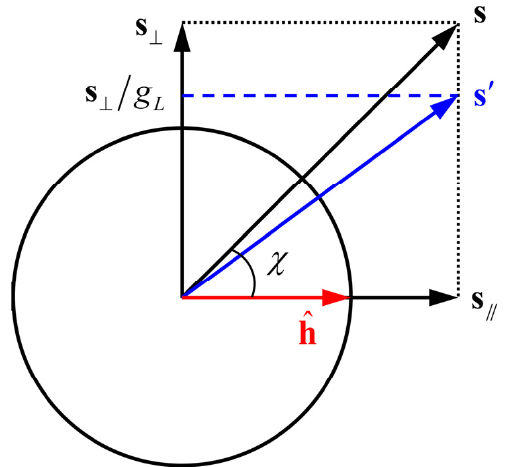
Figure 3. Schematic of the decomposition and composition of stress deviator [28]. Redraw with reference to International Journal of Plasticity, Vol 58, Barlat, F.; Vincze, G.; Gr á cio, J.J.; Lee, M.G.; Rauch, E.F.; Tom é , C.N., Enhancements of homogenous anisotropic hardening model and application to mild and dual-phase steels, 201–218, Copyright Elsevier (2014), with permission from